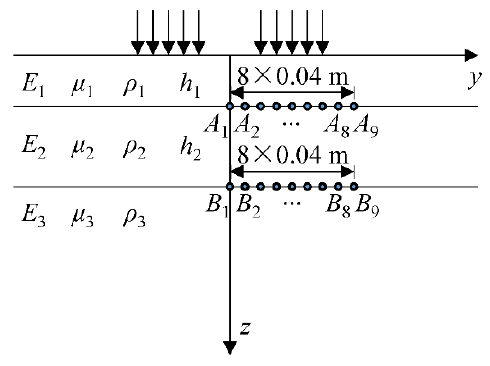
Figure 4. Calculation points inside the pavement.